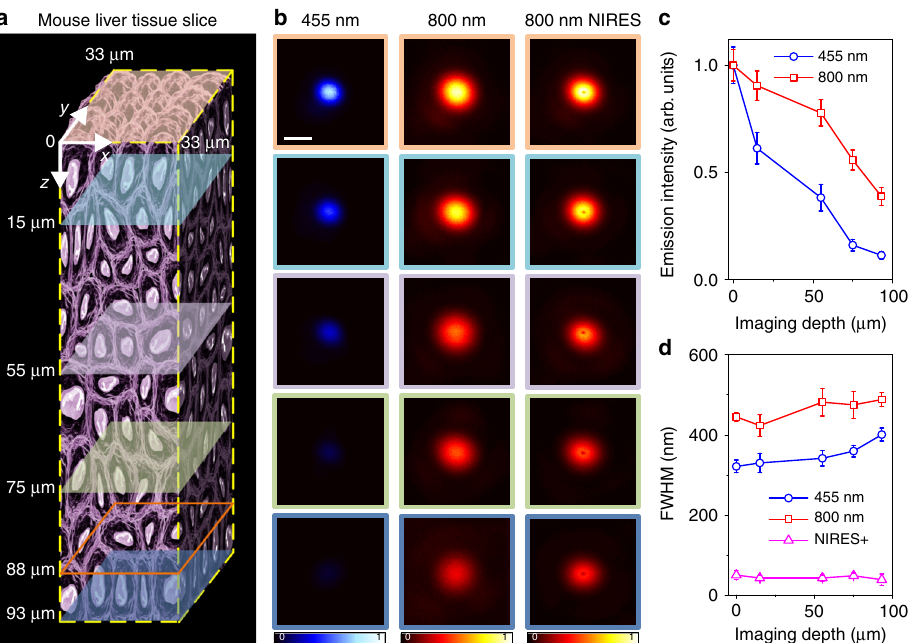
Fig. 4 The optical resolution of different imaging modalities at different depth of a liver tissue slice. a An illustration of a mouse liver tissue slice with 93 µ m thickness. b Single particle imaging at different depth in liver tissue. Left, confocal images from 455 nm emission; middle, confocal images from 800 nm emission; right, the corresponding NIRES images. c The normalized emission attenuation at different depth through the liver tissue. d The corresponding FWHM in b ; The resolutions of NIRES in d are 49.6 ± 11.1 nm (0 µ m), 42.4 ± 6.2 nm (15 µ m), 42.4 ± 7.2 nm (55 µ m), 48.0 ± 7.3 nm (75 µ m), 38.2 ± 14.3 nm (93 µ m). Detailed data in d is shown in Supplementary Table 3. Bene fi ting from the controlled synthesis of intensity monodispersed UCNPs, each single nanoparticle can be distinguished from their clusters from clusters by comparing their emission intensity to statistical averaged value[37,46 – 49]. Error bars are de fi ned as s.d. Pixel dwell time for confocal and NIRES is 3 ms. The pixel size for confocal and NIRES is 10 nm. The scale bar is 500 nm